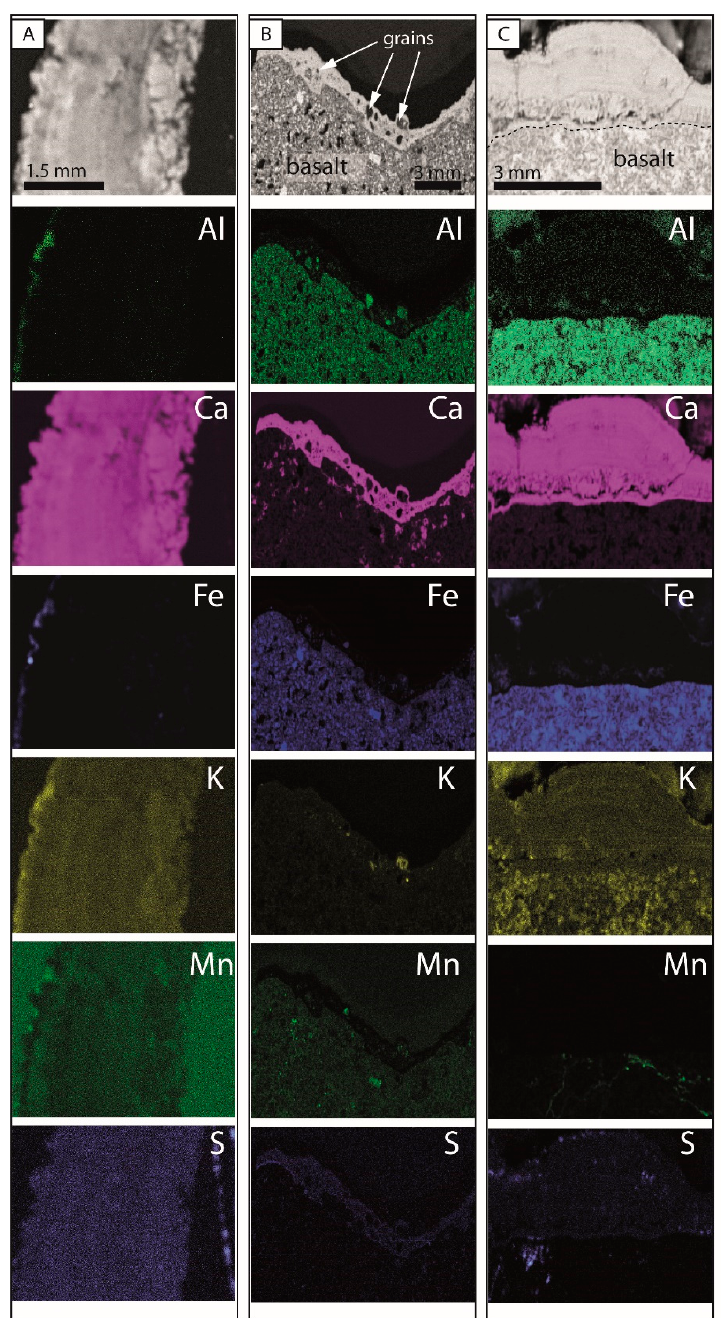
Figure 4. Microfluorescence mapping of elemental Al, Ca, Fe, K, Mn and S. ( A ) Dense crust. ( B ) Dense crust associated with extraclast and basalt substrate. ( C ) Dense crust on basalt substrate.